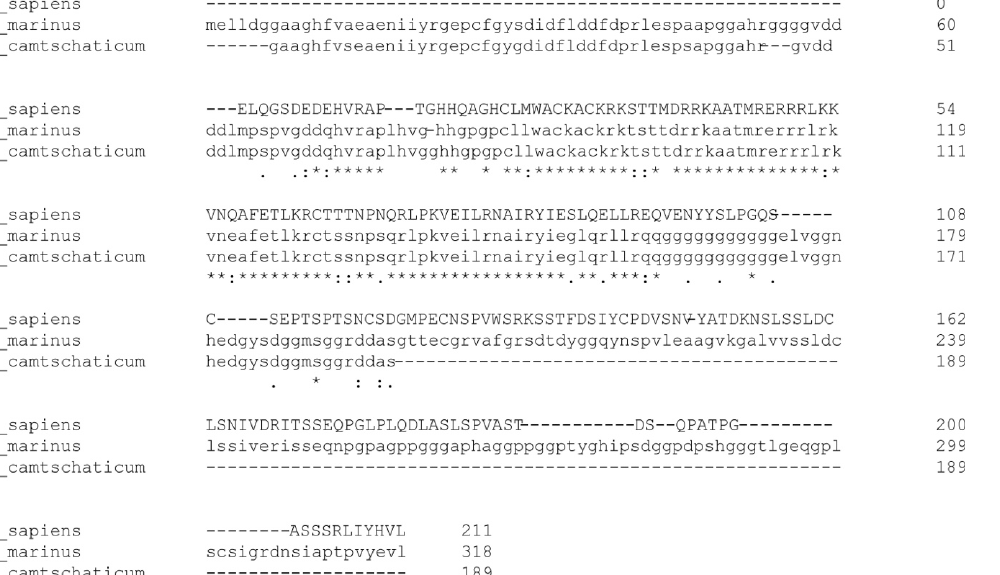
Figure 7. The conserved structure of river lamprey ( Lampetra fluviatilis ) myogenic factor Myf5. The amino acid sequences alignment of human Myf5 sequence (Gene ID: 4617) and lampreys orthologs: Petromyzon marinus factor 5-like (NCBI Reference Sequence: XP_032827047.1) and Lethenteron camtschaticum myogenic regulatory factor MRF-A (GenBank: ADP37889.1). An * (asterisk) indicates positions that have a single, fully conserved residue; A: (colon) indicates conservation between groups of strongly similar properties, equivalent to scoring > 0.5 in the Gonnet PAM 250 matrix; A: (period) indicates conservation between groups of weakly similar properties, equivalent to scoring =< 0.5 and > 0 in the Gonnet PAM 250 matrix. The amino acid sequence alignment was performed using Clustal Omega, version 1.2.2, currently maintained at by Des Higgins, Fabian Sievers,